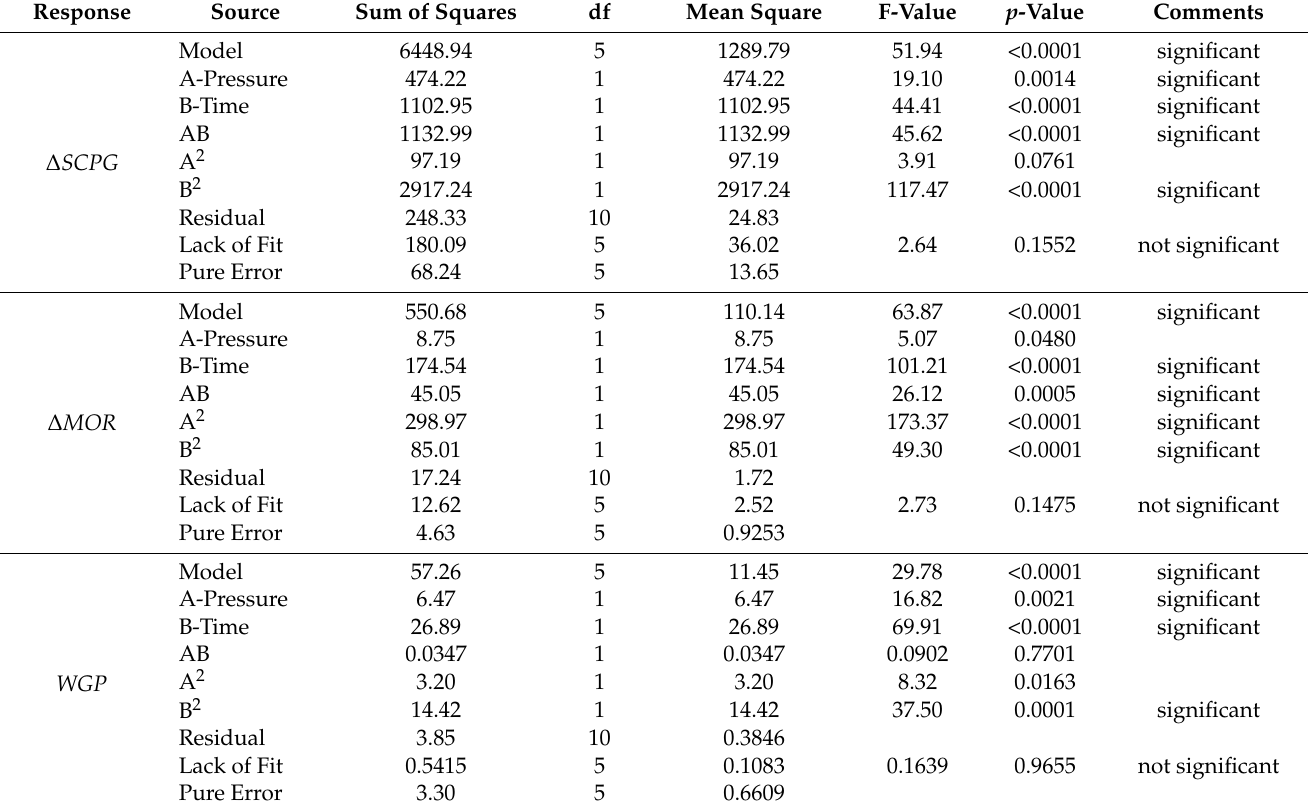
Table 4. Analysis of variance (ANOVA) for the quadratic models of ∆ MOR , ∆ SCPG , and WGP